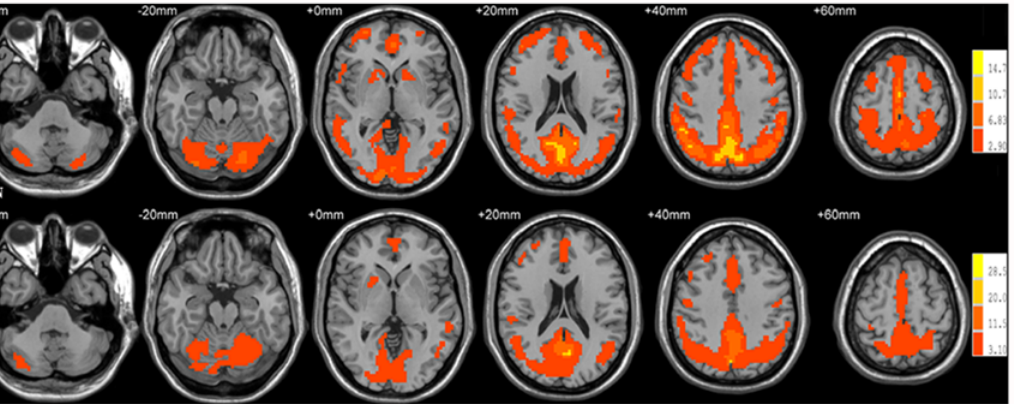
Fig 1. Results of one-sample t -test on ReHo maps for healthy controls (CON, uppper) and patients with acute SCI (SCI, lower). Threshold was set to p < 0.05 with AlphaSim correction. The left side of the image corresponds to the right hemisphere of the brain. The underlying structure image is Ch2